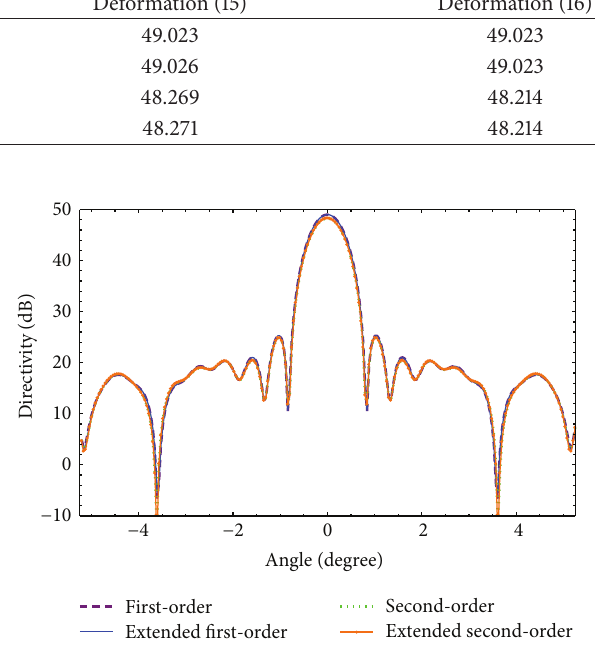
Figure 4: Far field pattern comparisons of the extended formula with the previous one under deformation (14).